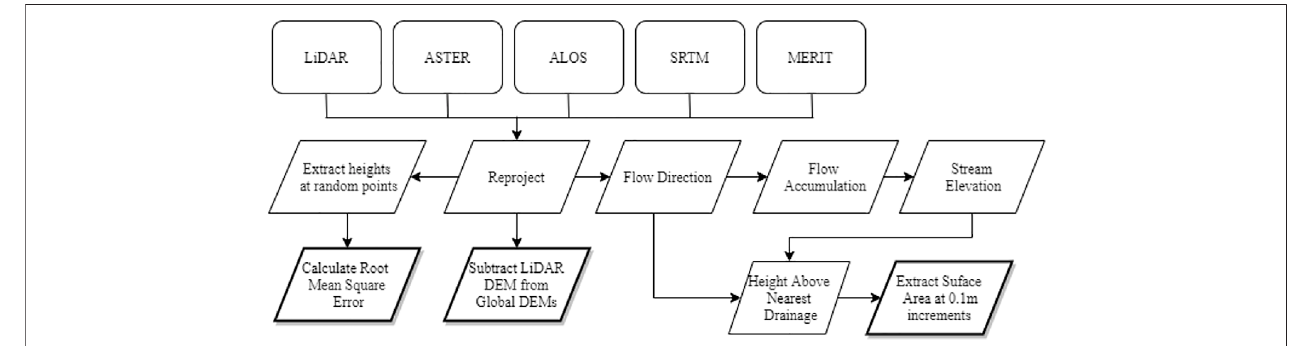
FIGURE 2 | Flow chart of the three primary comparisons performed between the DEMs.